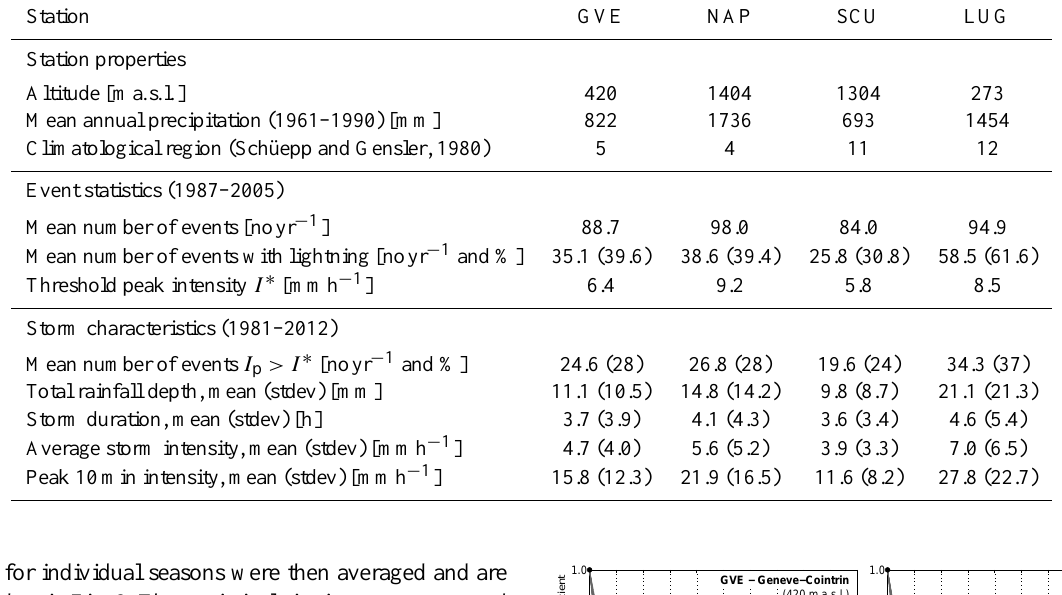
Table 1. Main properties of the four selected SwissMetNet stations in this analysis: Geneve-Cointrin (GVE), Napf (NAP), Scuol (SCU) and Lugano (LUG). The storm statistics shown are for the warm season (April–September) with an additional constraint that air temperature T > 4 ◦ C during an event. Station GVE